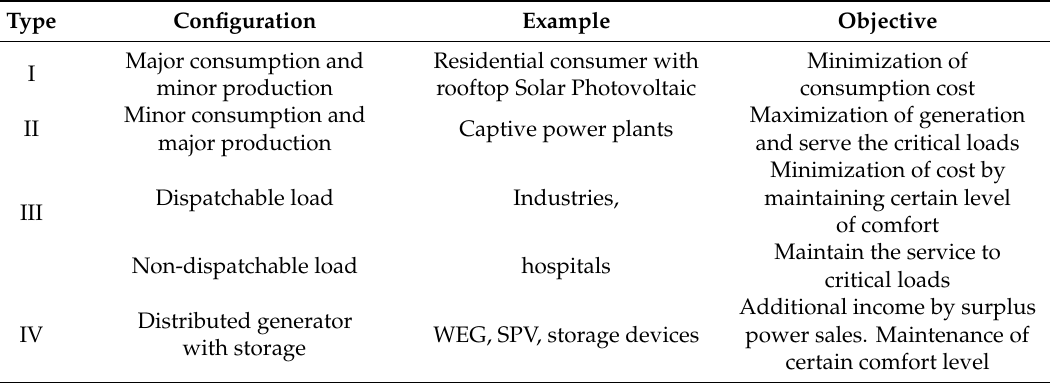
Table 1. Types of energy